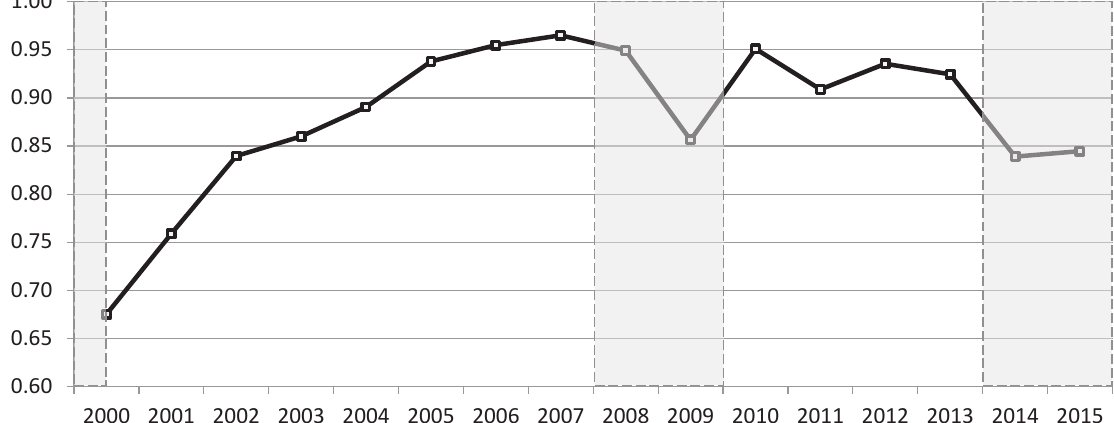
Figure 4. Graphical representation of the index of economic sustainability of the country’s socio-economic system fo the period 2000–2015